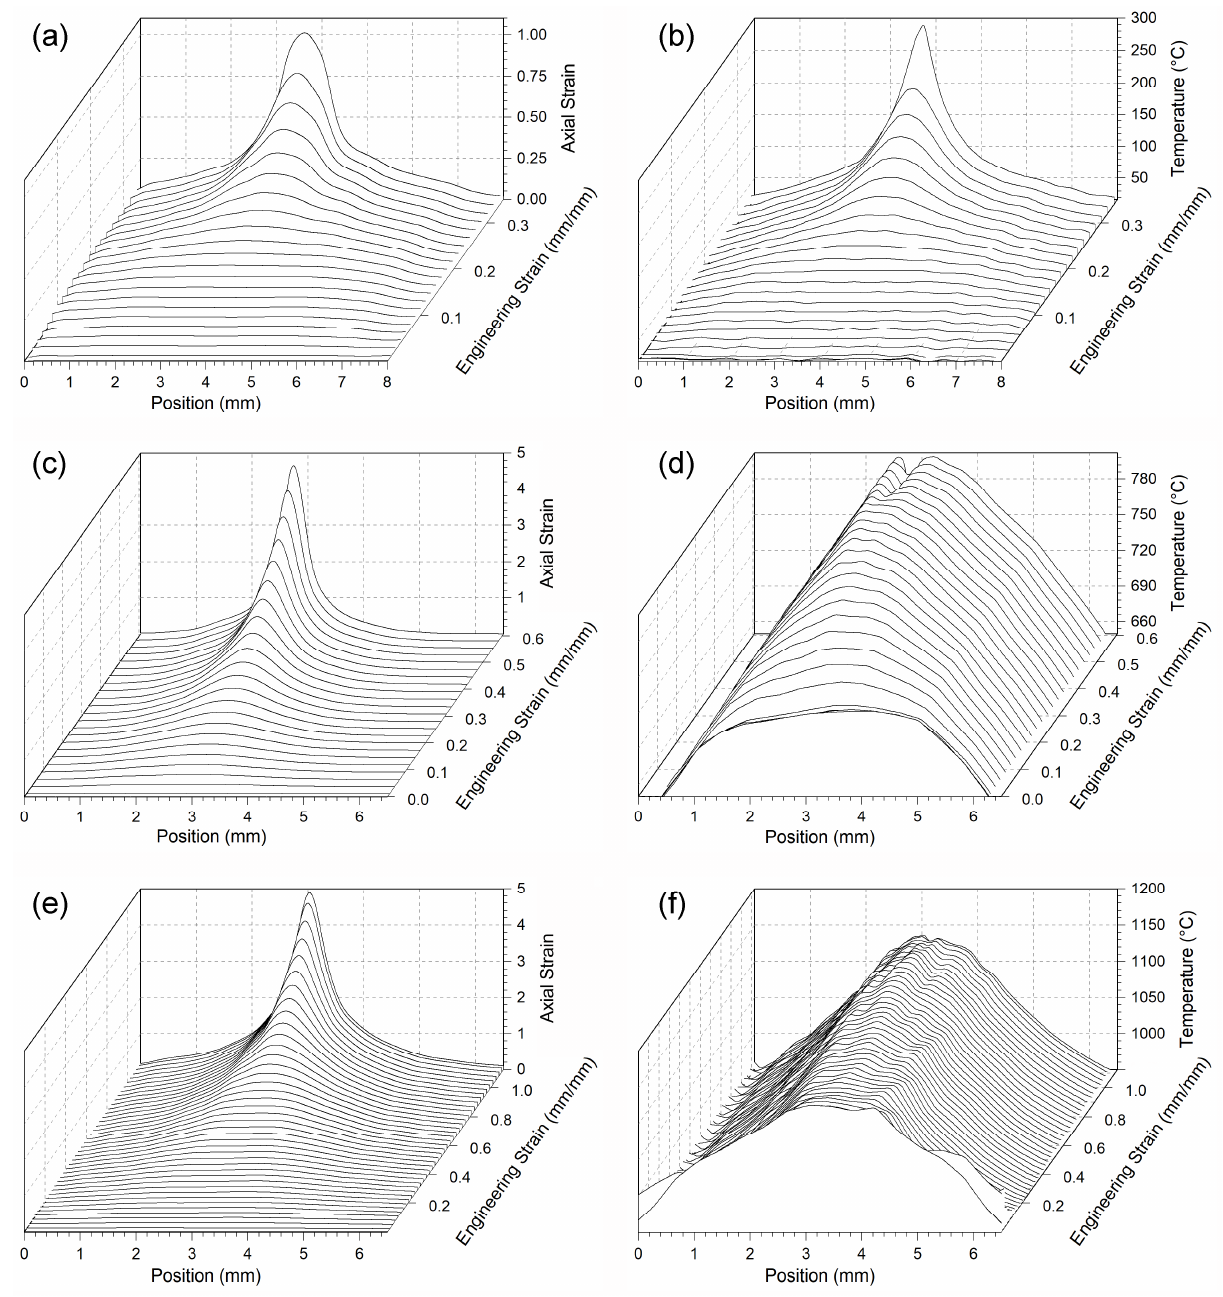
Figure 19. Three-dimensional waterfall plots of axial strain ( a , c , e ) and surface temperature ( b , d , f ) of commercially pure titanium tested in tension at a strain rate of approximately 1600 s −1 at ( a , b ) room temperature, ( c , d ) 700 °C, and ( e , f ) 1120 °C.